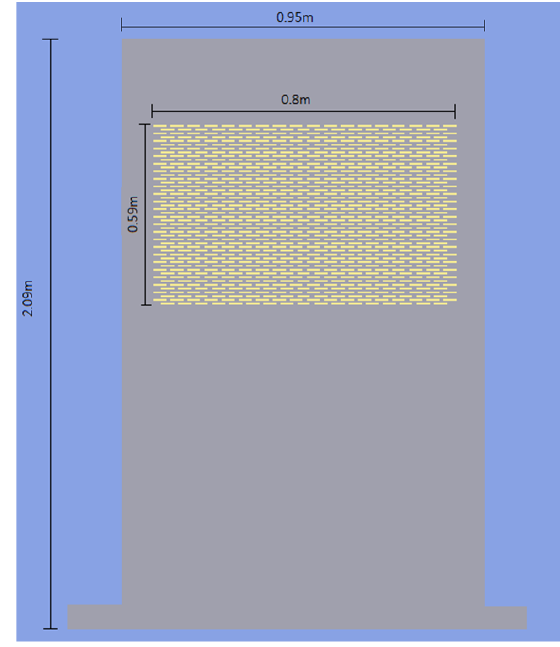
Figure 2. Air purifier model diagram (front).